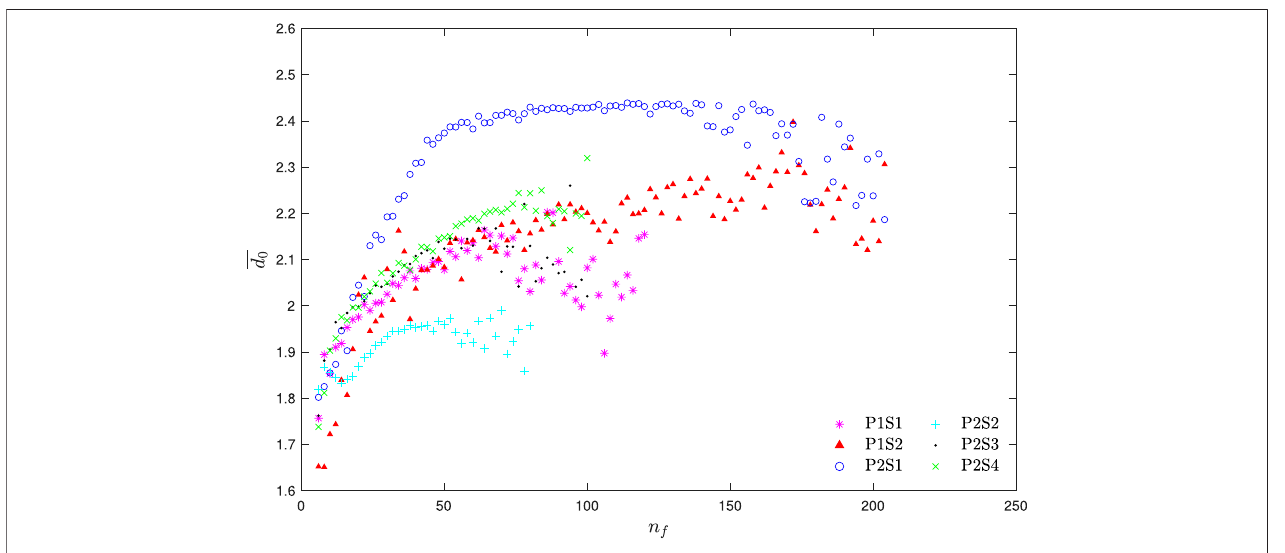
FIGURE 12 | Averaged fractal dimension ( d 0 ) as function of fl oc size n f for different cases.